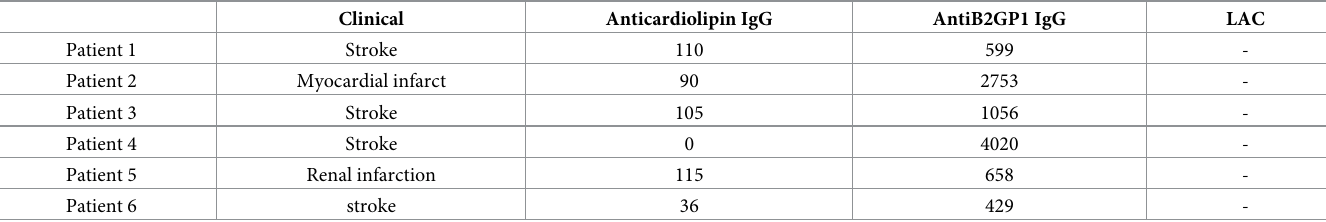
Table 1. Antiphospholipid syndrome patients and antiphospholipid antibody (aPL)-binding